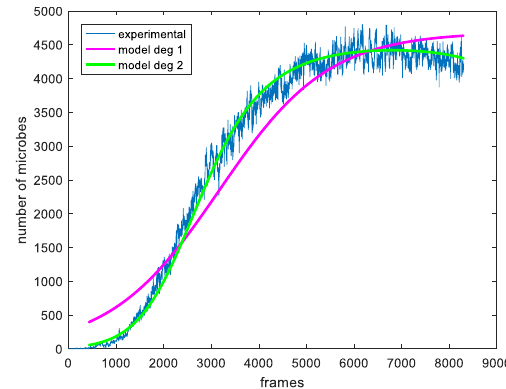
Figure 5. The experimental curve of the fungi on the whole plate is illustrated in blue and the modeling of the logistic function (LF) with linear and square exponent with pink and green,